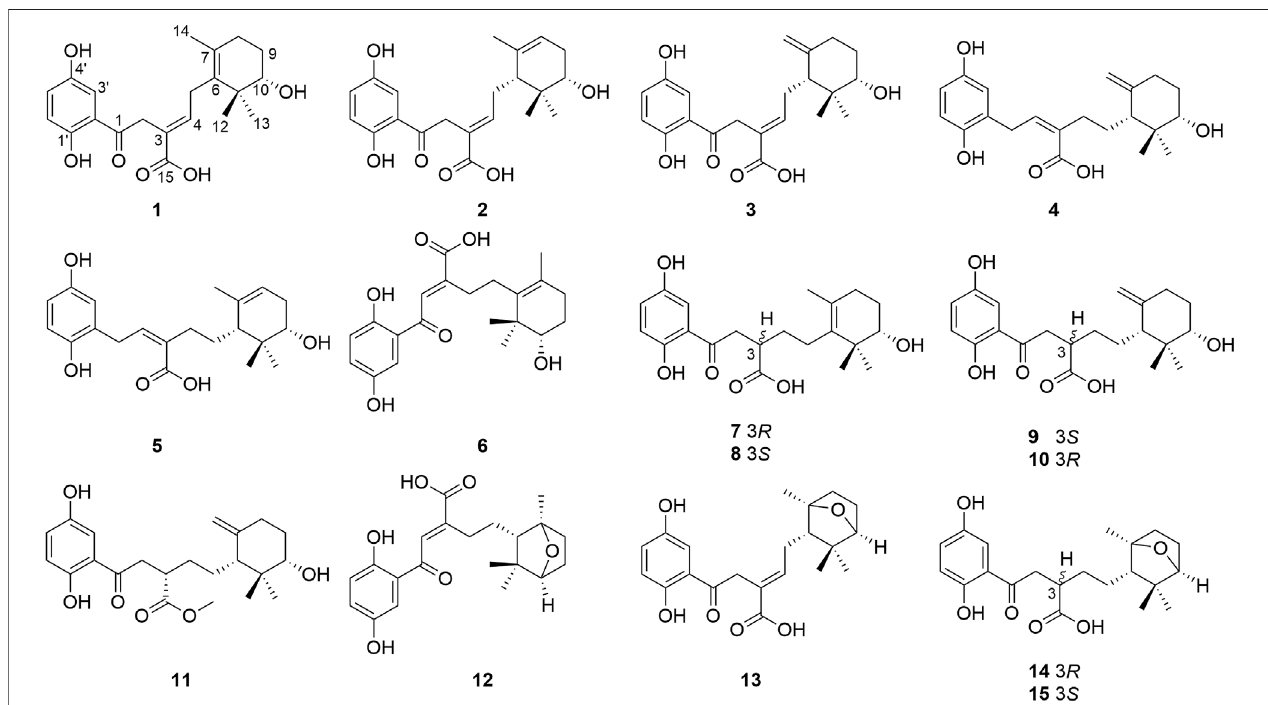
FIGURE 1 | Structures of 1 – 15 isolated from G.